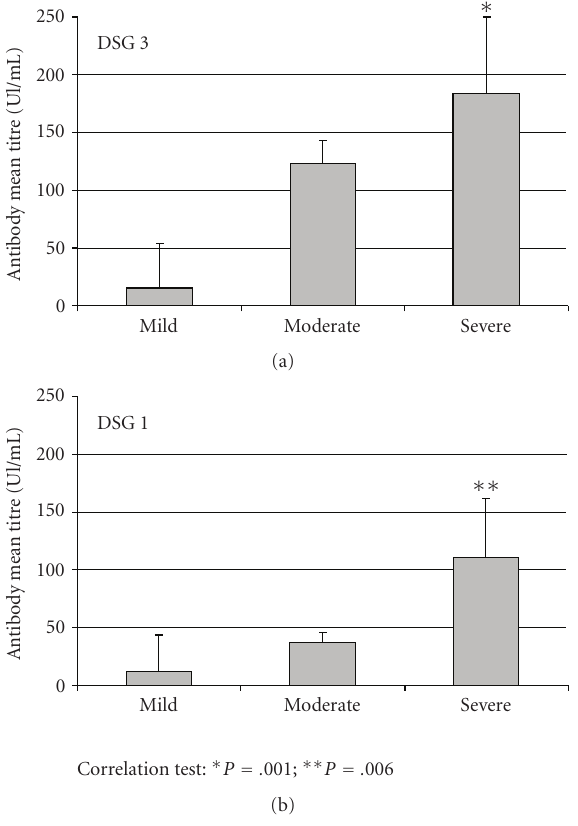
Figure 2: Anti-DSG3 and anti-DSG1 autoantibody mean titres in presence of skin involvement.